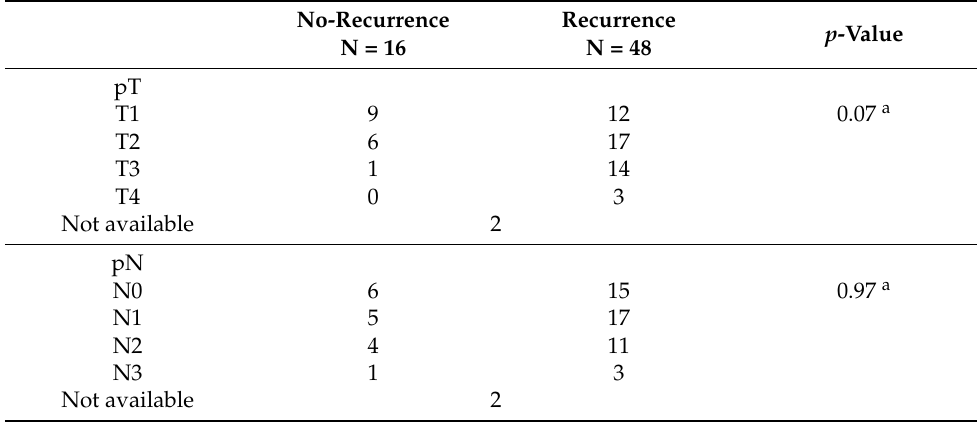
Table 2. Comparison of prognostic powers of various histopathological and biological parameters for diagnosing first recurrence in 64 patients with suspected first ILC